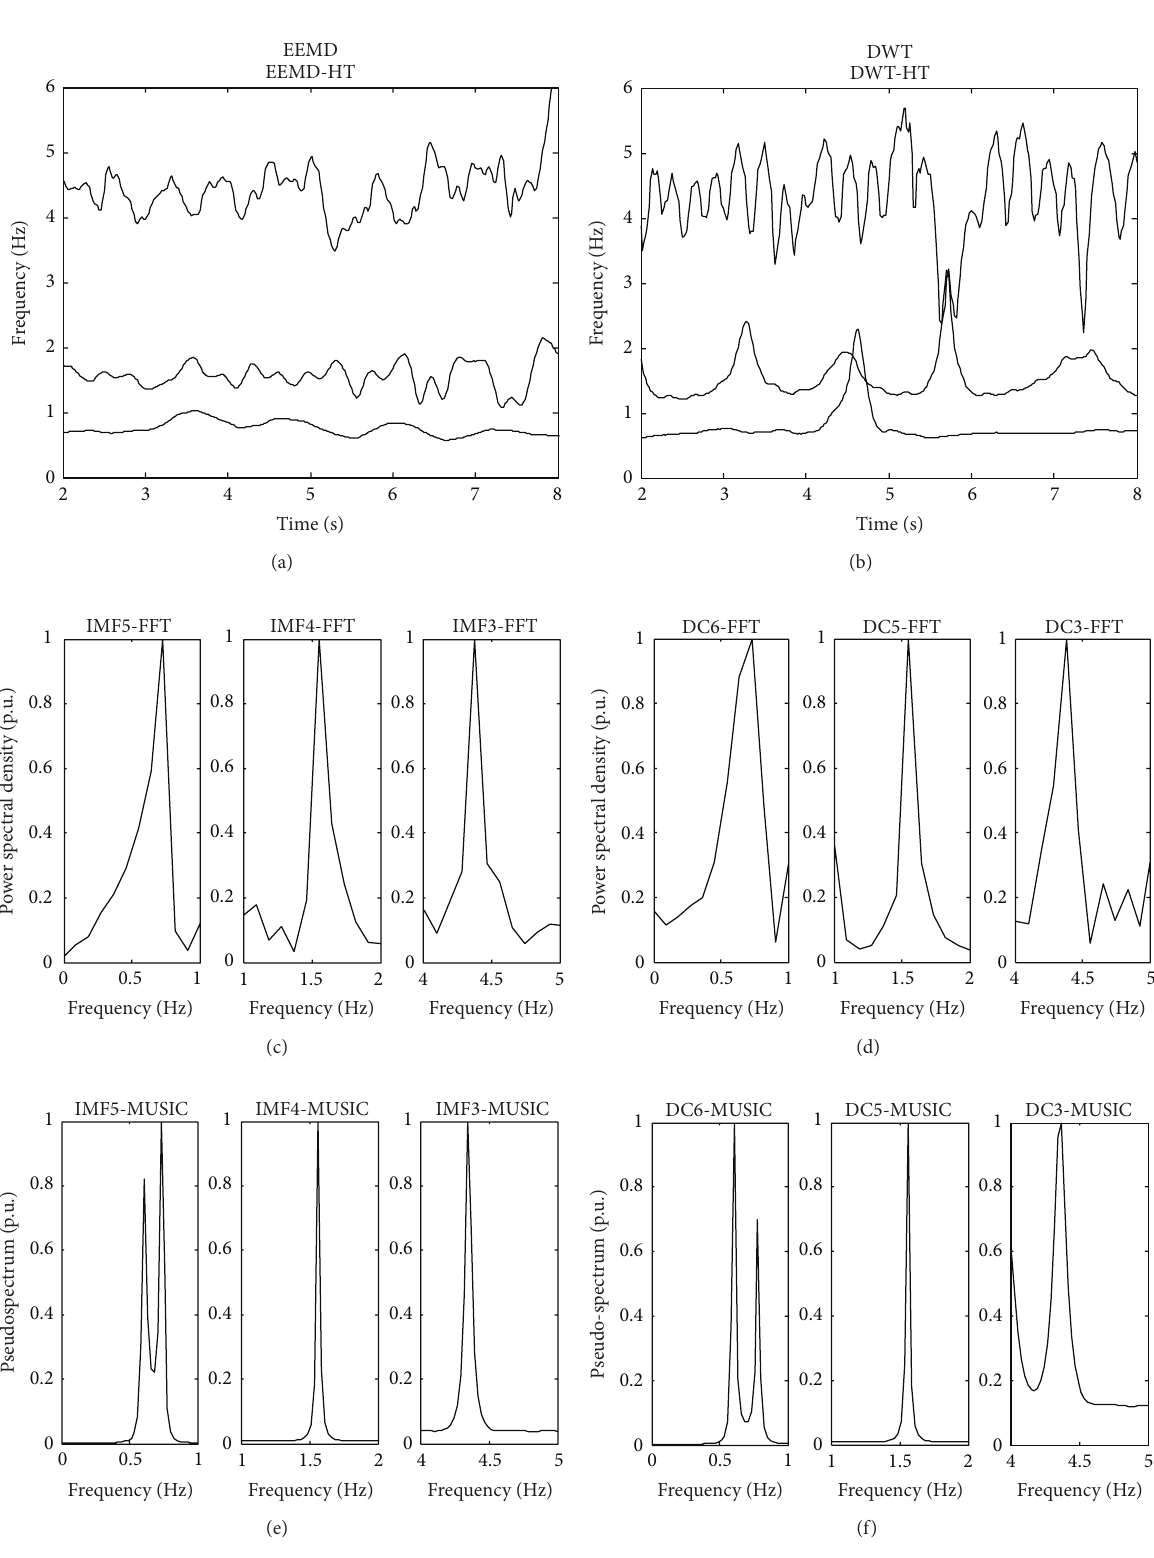
Figure 4: Results obtained by (a) EEMD-HT method, (b) DWT-HT, (c) EEMD-FFT, (d) DWT-FFT, (e) EEMD-MUSIC, and (f) DWT-